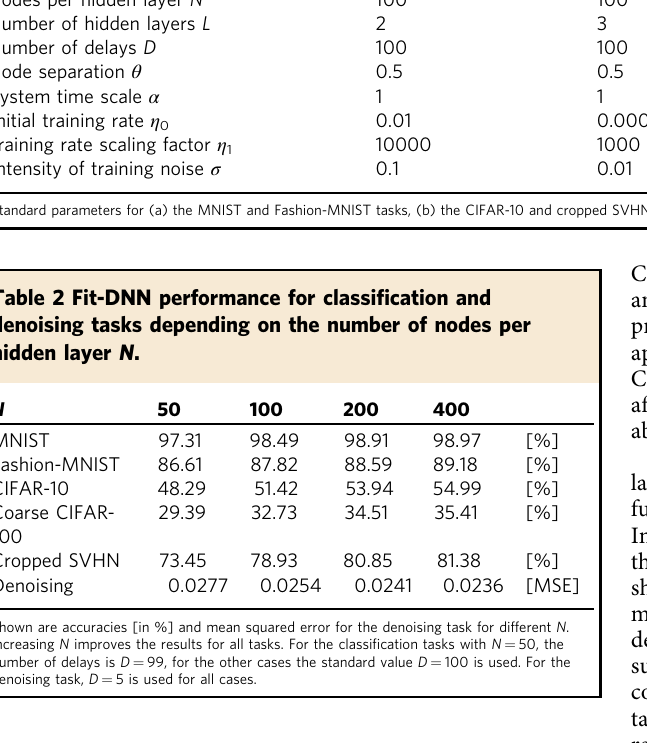
Shown are accuracies [in %] and mean squared error for the denoising task for different N . Increasing N improves the results for all tasks. For the classi fi cation tasks with N = 50, the number of delays is D = 99, for the other cases the standard value D = 100 is used. For the denoising task, D = 5 is used for all cases.